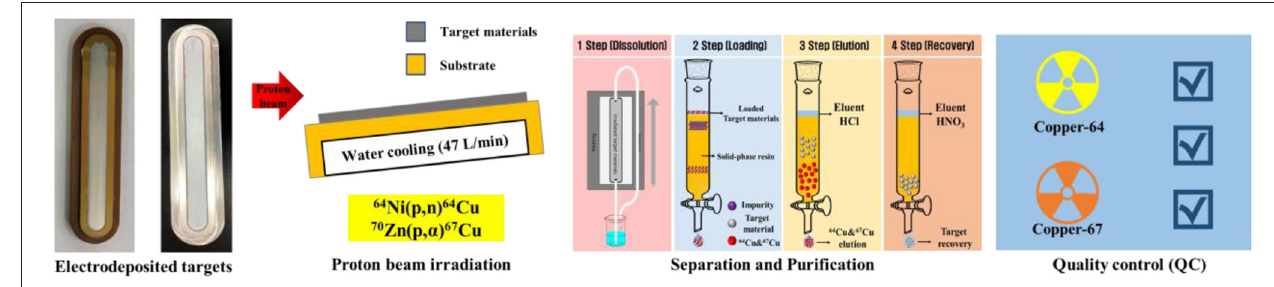
FIGURE 1 | Schematic illustration of pair-radioisotope production route.